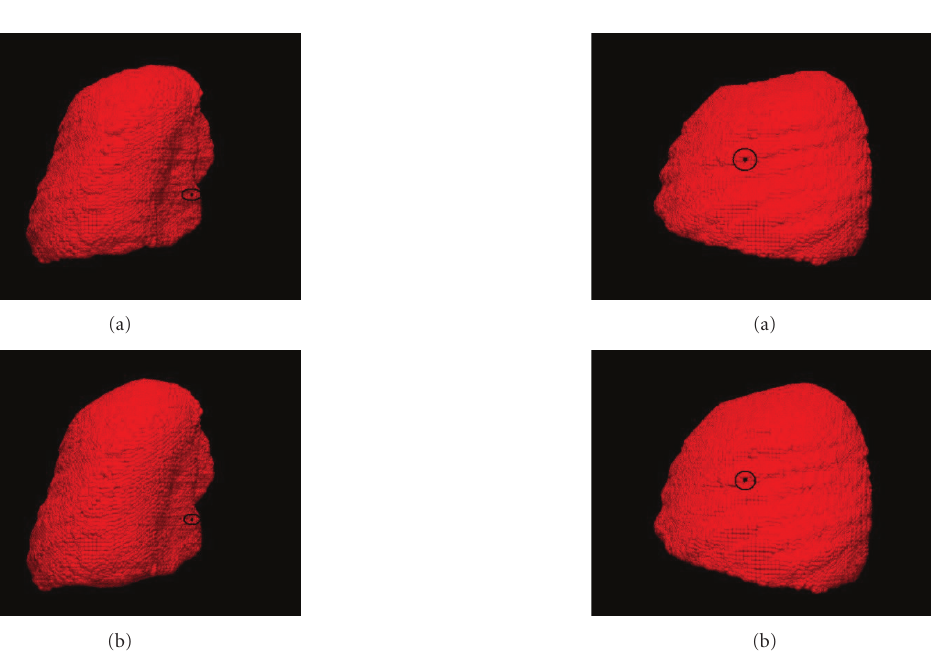
Figure 5: Simulated result of lung deformation at initial stage of inspiration (a) and end of inspiration (b). The dotted mark is the position S6.